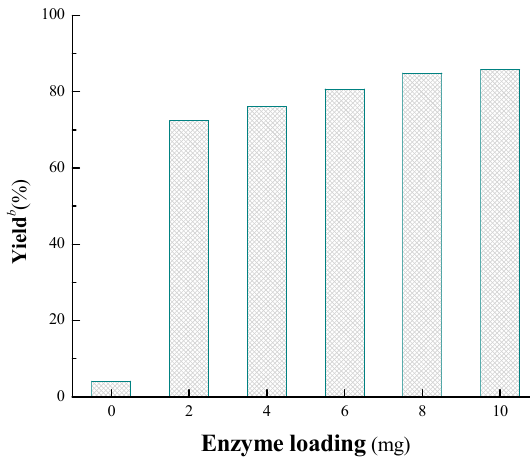
Figure 3. Influence of the enzyme loading on the cascade reaction a .